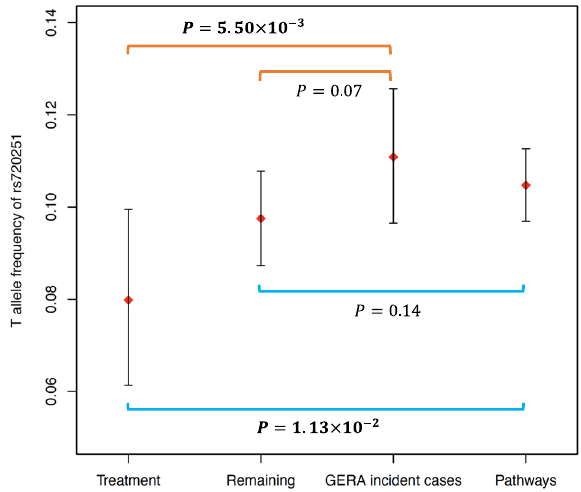
Fig. 5 Comparison of risk allele (T) frequency of rs720251 in the GERA prevalent cases with its population frequency. The “ treat- ment ” and “ remaining ” group correspond to the GERA prevalent patients with and without Par-4 dependent chemotherapies respectively. T allele frequency at population level was estimated using the GERA incident cases or using all European-descent patients from the Pathways Study ( “ Pathways ” ). The estimated T allele frequency as well as its 95% con fi dence interval from 10,000 bootstrap samples were plotted. The P -values were calculated by comparing the T allele frequency between the two corresponding groups connected by the brackets in the plot from the 10,000 bootstrap replications. Signi fi cant P -values ( ≤ 0.05) were in bold.